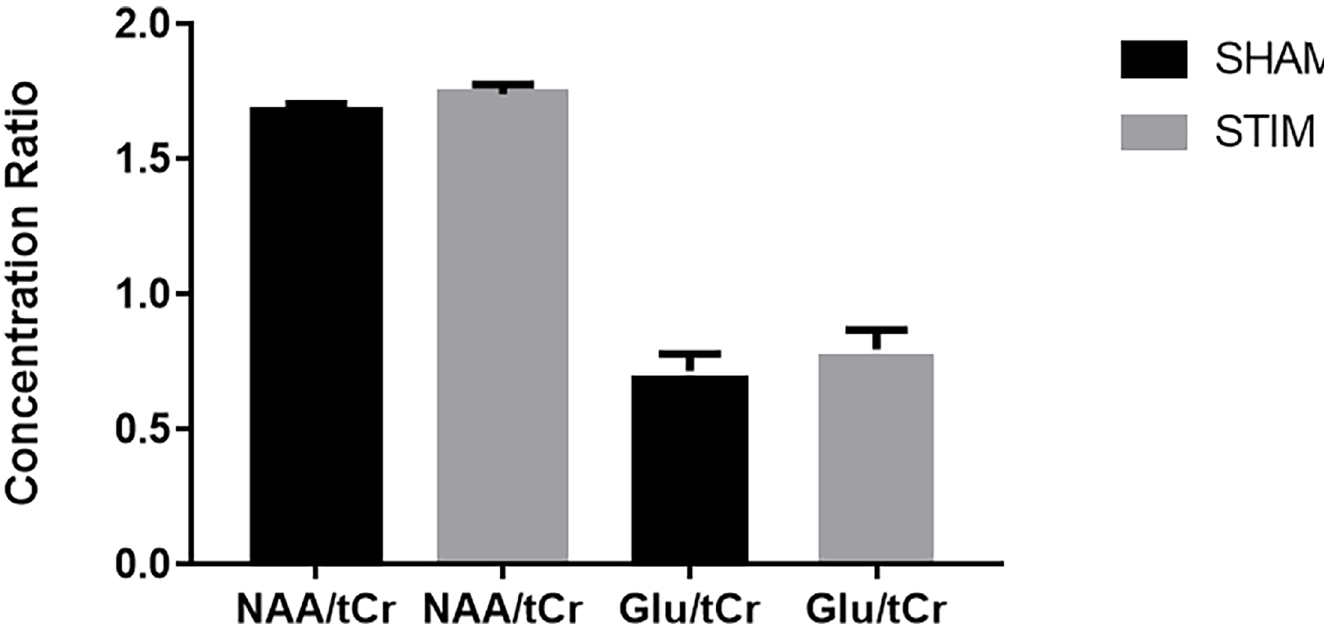
Fig 3. Metabolic ratios–sham vs stim. tDCS increases NAA/tCr ratio when measured immediately after a 20 minute stimulation period ( (cid:3) p = 0.08). No difference was observed in Glu/Cr. Error bars indicate SEM.